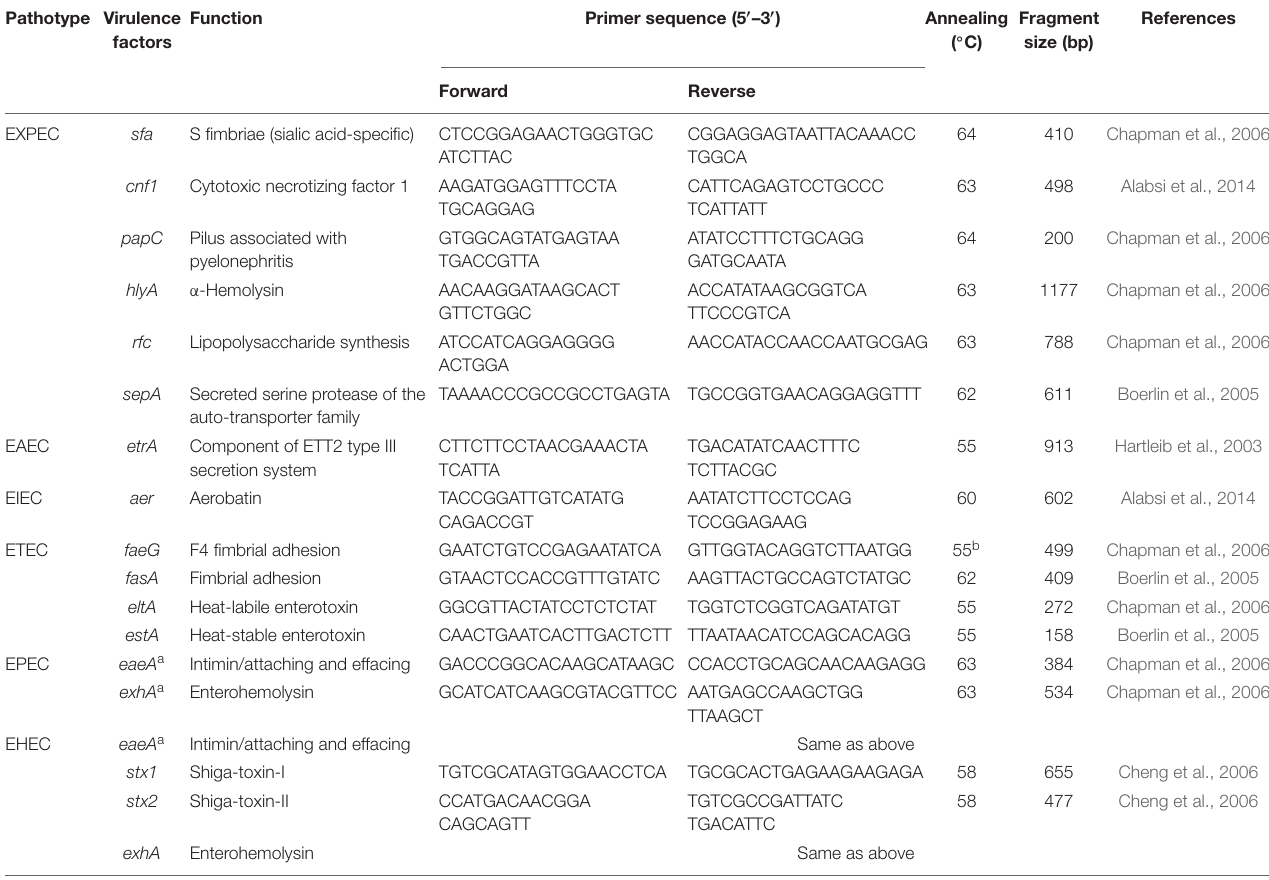
TABLE 1 | List of 16 virulence genes detected in the present study, categorized based on their association with E. coli pathotypes. Pathotype Virulence factors